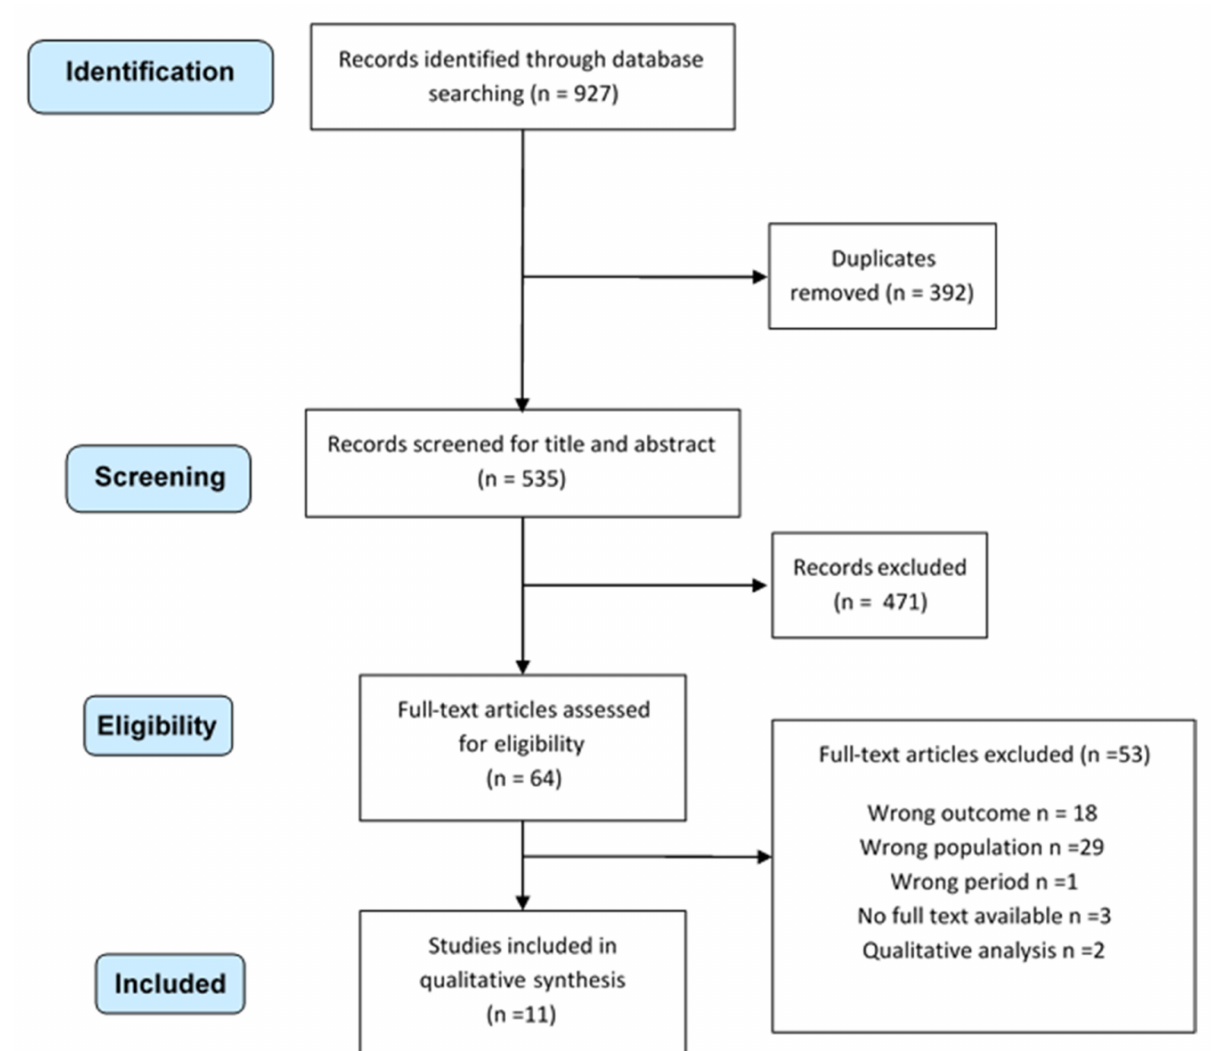
Figure 1. Systematic review selection